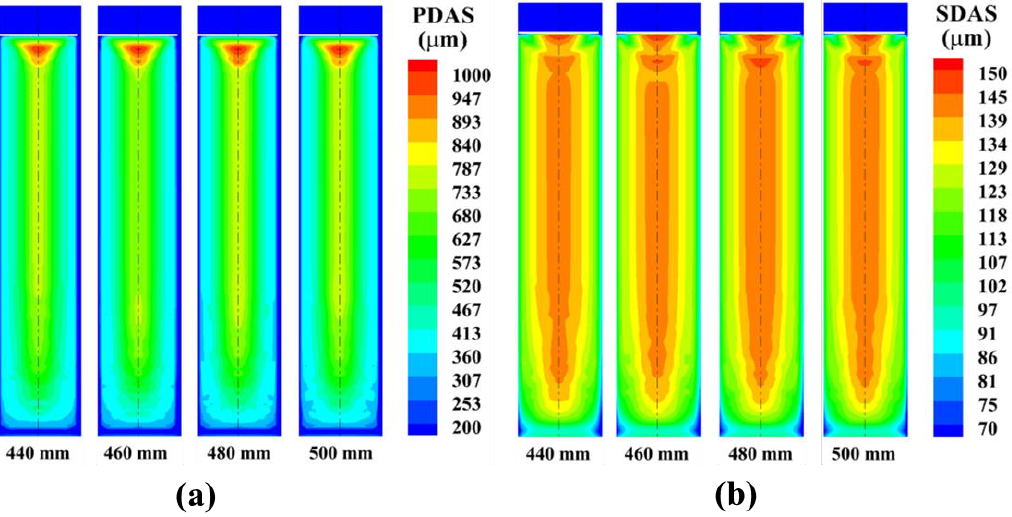
Figure 3. The influence of electrode diameter on the distribution of ( a ) primary and ( b ) secondary dendrite spacing.